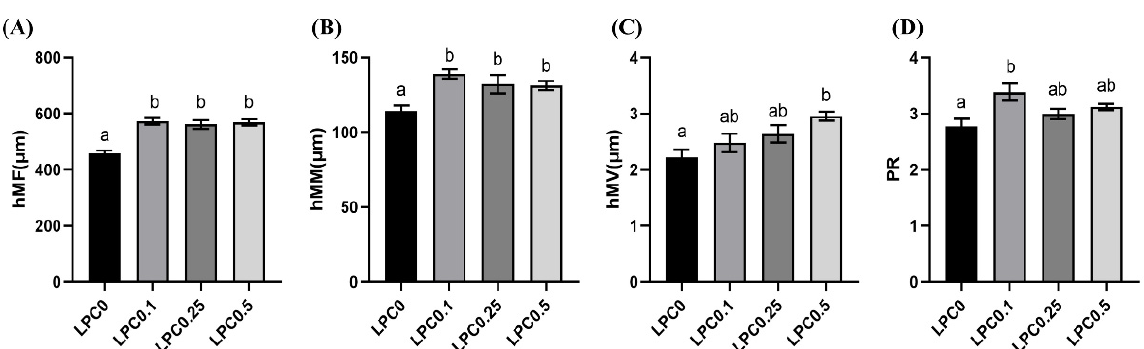
Figure 2. Intestinal histology parameters. ( A ) The height of mucosal folds (hMF); ( B ) The height of muscularis mucosa (hMM); ( C ) The height of microvilli (hMV); ( D ) perimeter ratio (PR). Results were expressed as means ± S.E., and different superscript letters indicate significant differences ( p < 0.05).